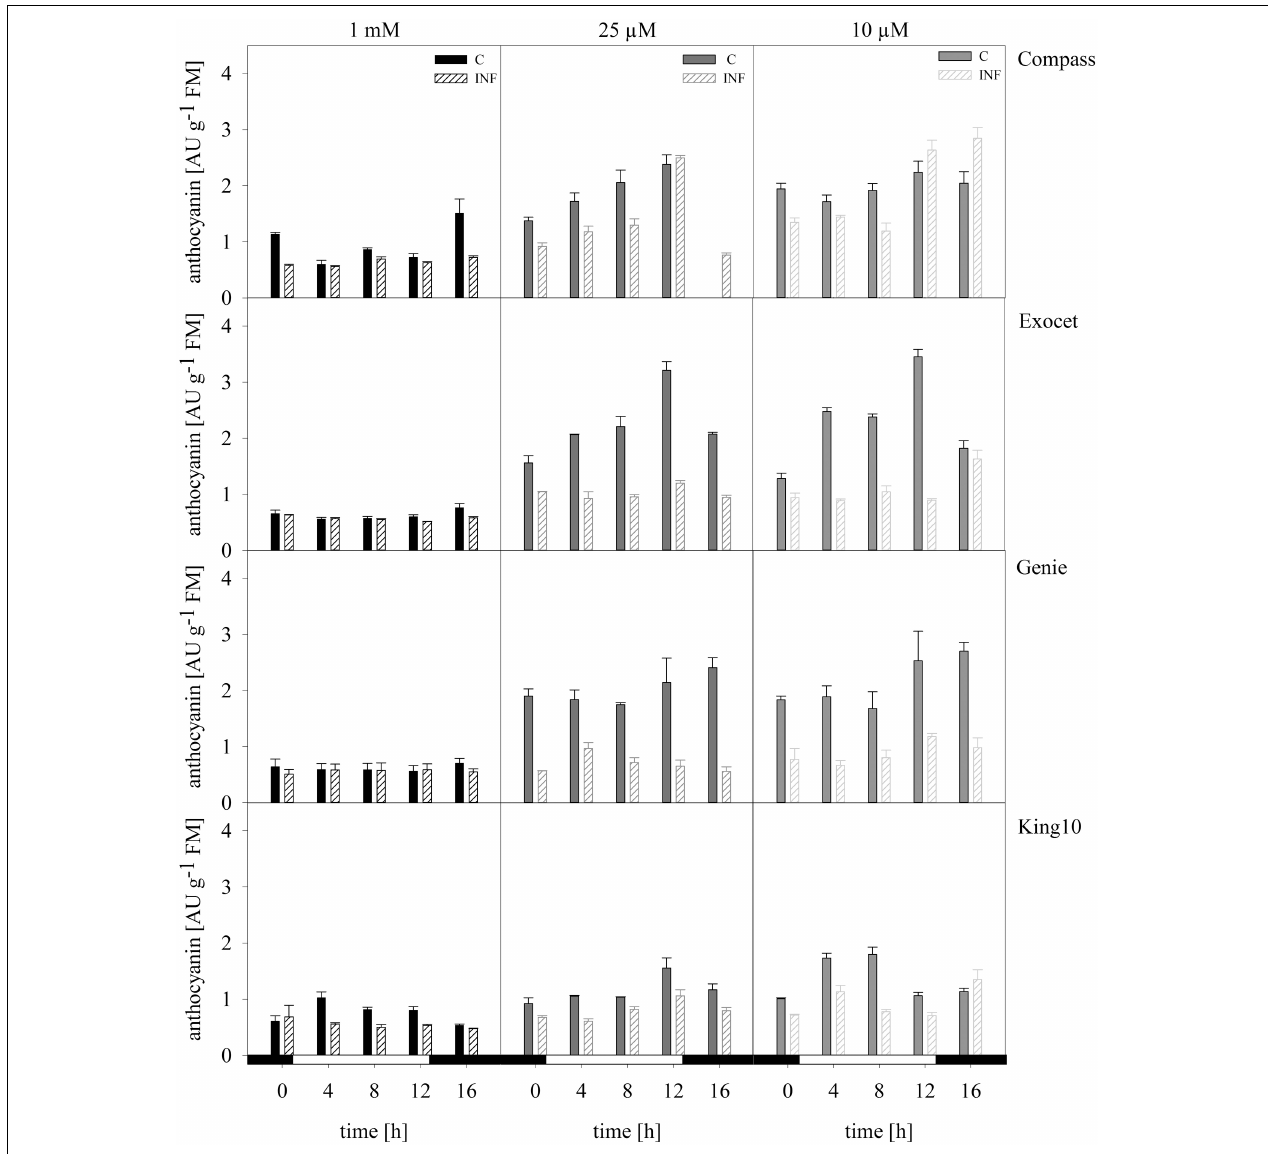
of technical replicates, which were measured three times. Filled bars represent the control plants (C) for different sulfur fertilization and striped bars indicate infected plants (INF). AU, absorbance